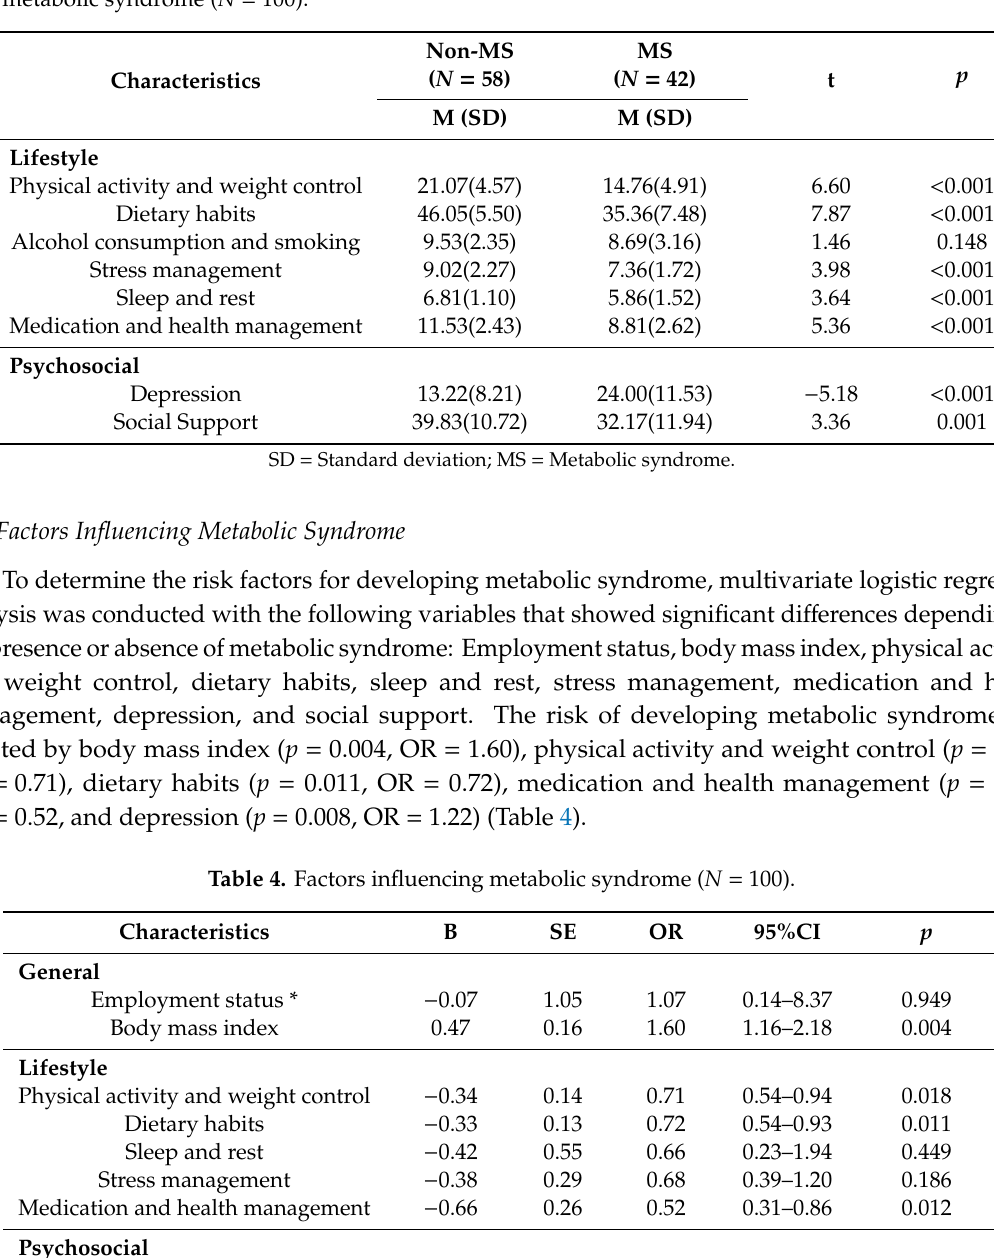
Table 3. Comparison of the characteristics of lifestyle and psychosocial factors with and without metabolic syndrome ( N = 100).